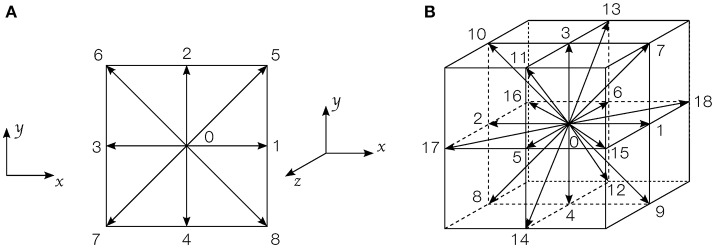
Discrete velocities arrangement on a lattice cell: (A) D2Q9 lattice; (B) D3Q19 lattice.